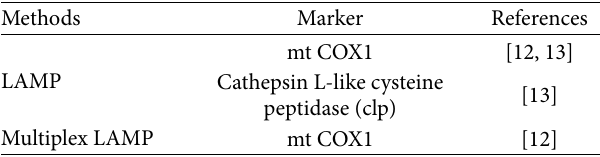
Table 3: LAMP assays for Taenia solium identification. Methods